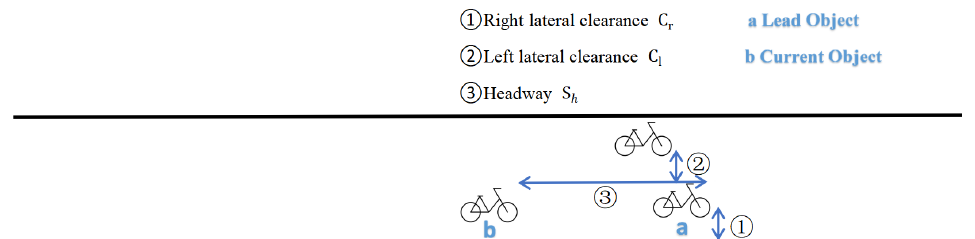
Figure 3. Schematic diagram of parameters related to following/overtaking decision/free move- ment decision.